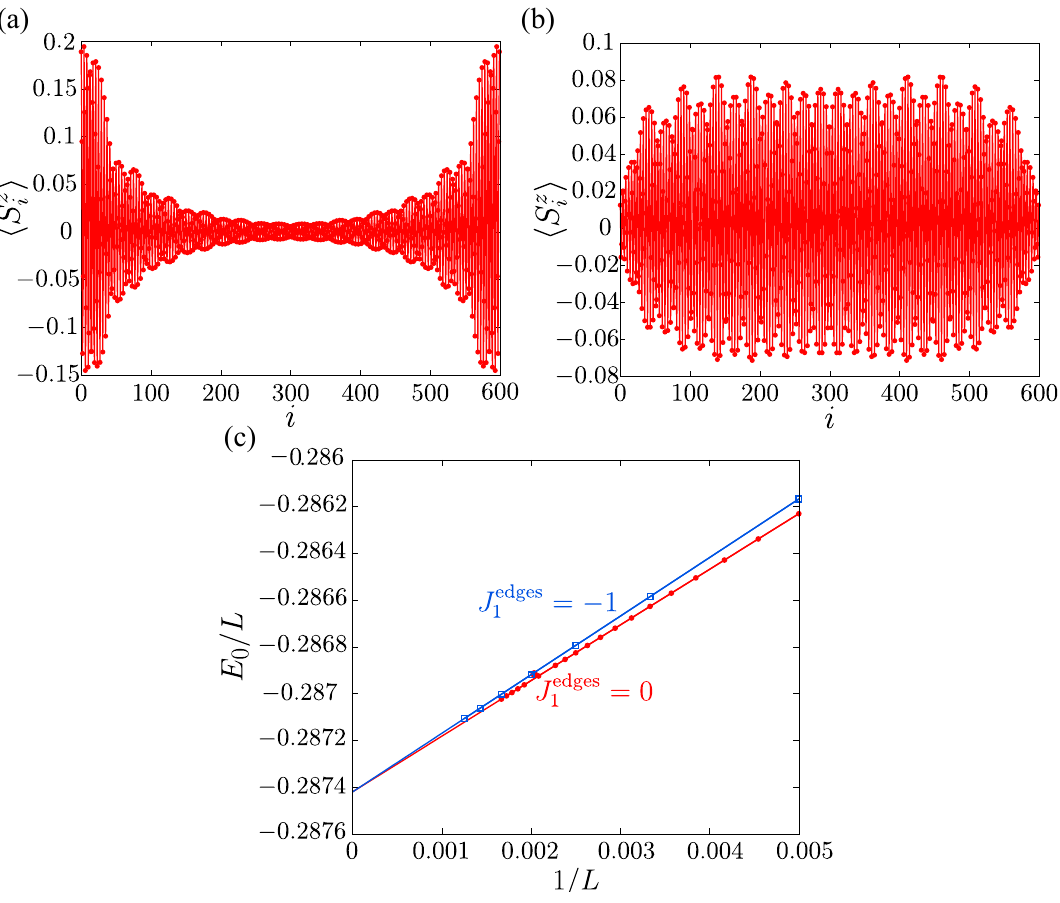
〉 in the first-excited Figure 2: Expectation value of the z -component of local spin 〈 S z i triplet state (total S z = 1) as a function of site position i at α = 0.6 with L = 600 for = − 1 and (b) J edge = 0. (c) Finite-size scaling of the lowest-state energy (a) J edge 1 1 = − 1 and J edge = 0 at α = 0.6. A linear fitting is performed with total S z = 0 for J edge 1 1 in both